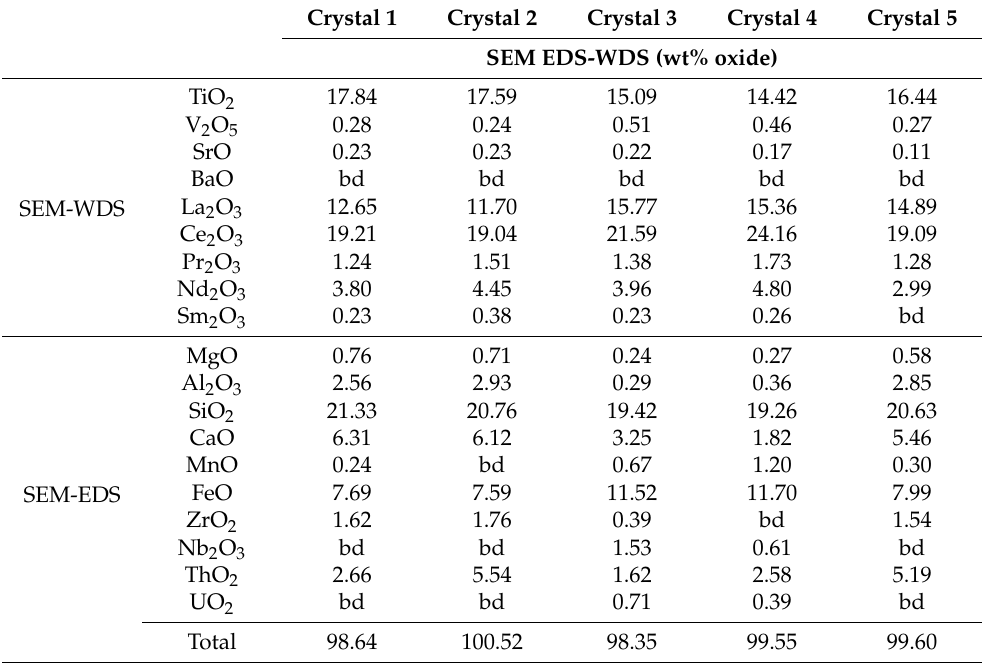
Table 4. Results of SEM EDS-WDS of quantitative analysis of five different chevkinite crystals using the analytical protocol developed in this study. bd = below detection.